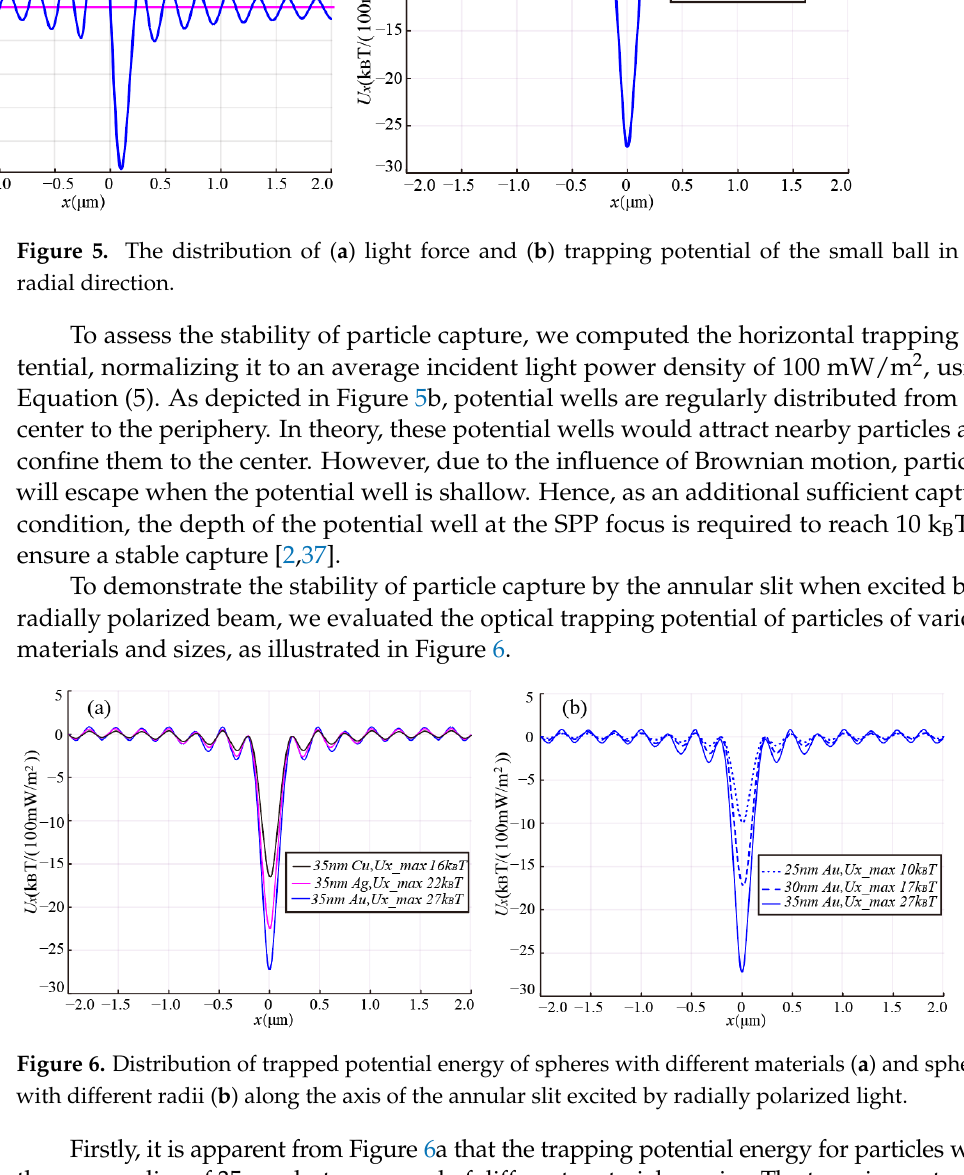
7 of 10 Figure 4. Electric field distribution ( a ) and optical force distribution ( b ) at the center of the annular slit excited by radially polarized light.